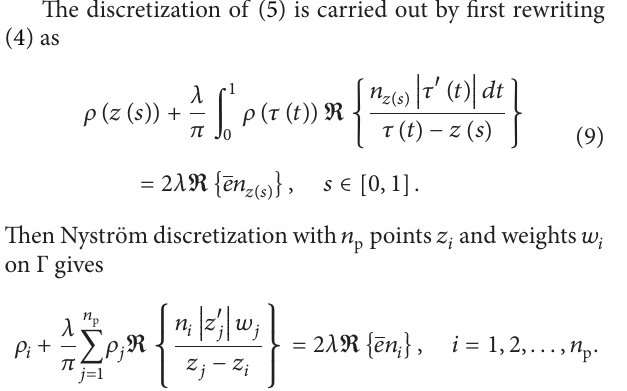
Figure 1: The contour Γ of (1) with a corner at the origin. The solid curve corresponds to opening angle 𝜃 = 𝜋/3 . The dashed curve has 𝜃 = 4𝜋/3 .